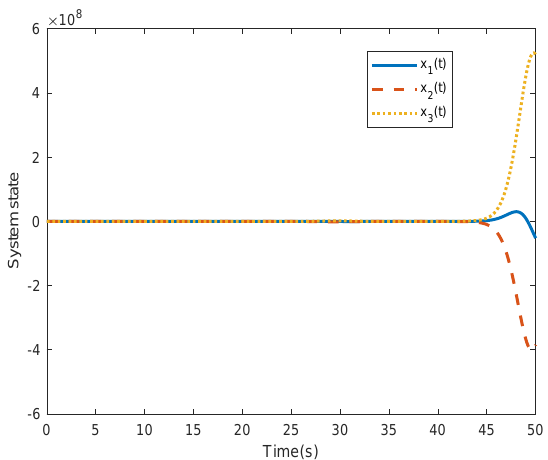
Figure 3. x ( t ) for system (1) without control law (23).